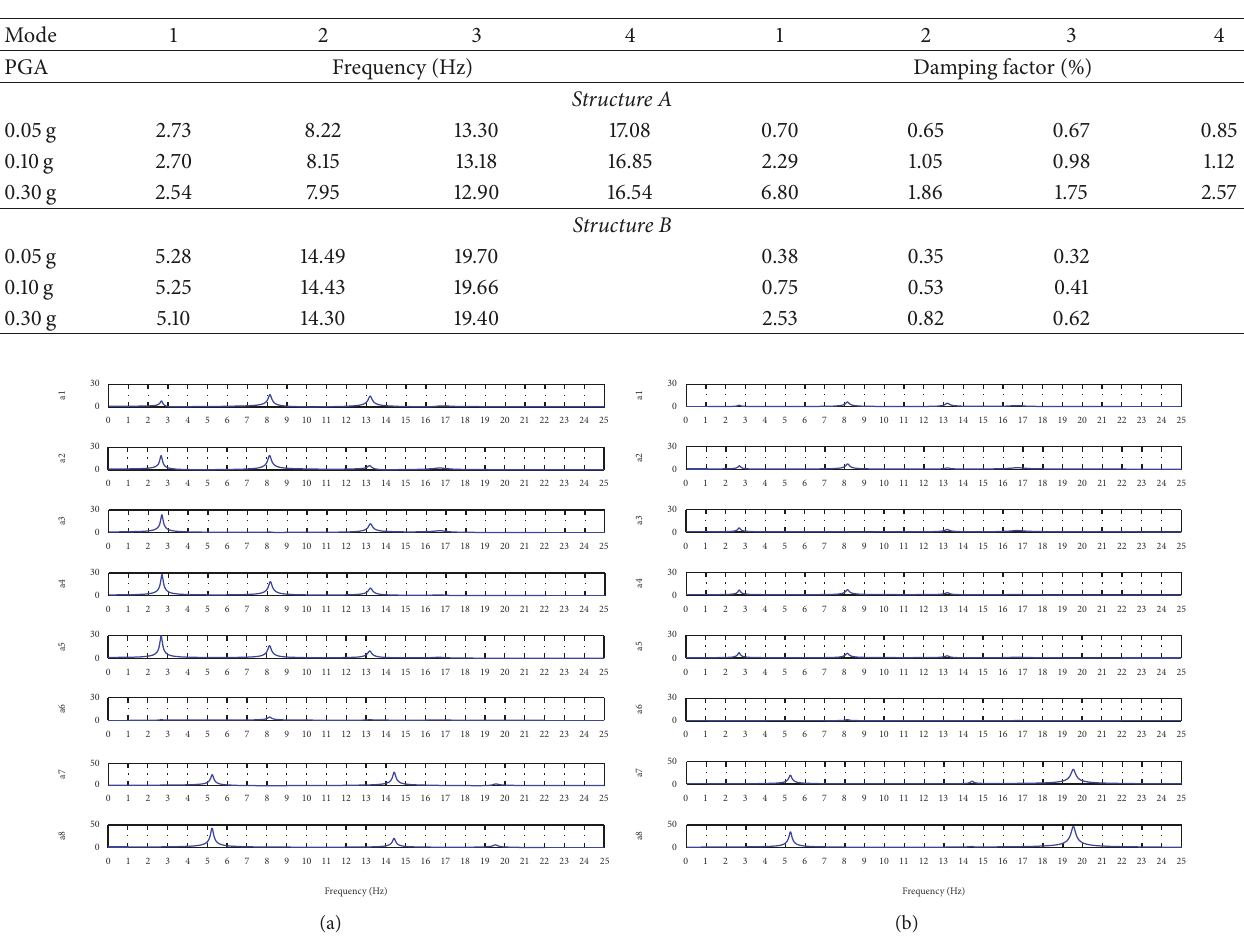
Table 1: Nonconnected (NC) configuration. Structures A and B identified frequencies and damping factors versus PGA.